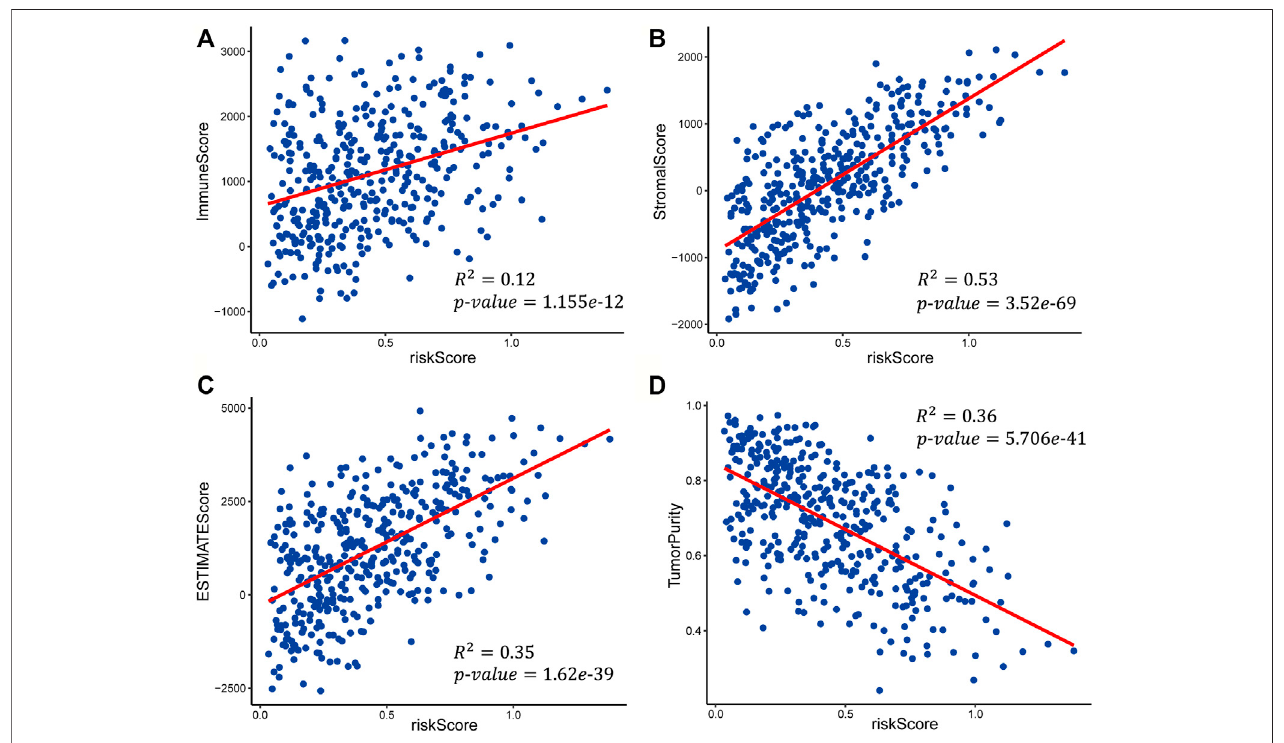
FIGURE 7 | Scatter plots of the linear fi t of risk score with (A) immune score, (B) stromal score, (C) ESTIMATE score, and (D) tumor purity.